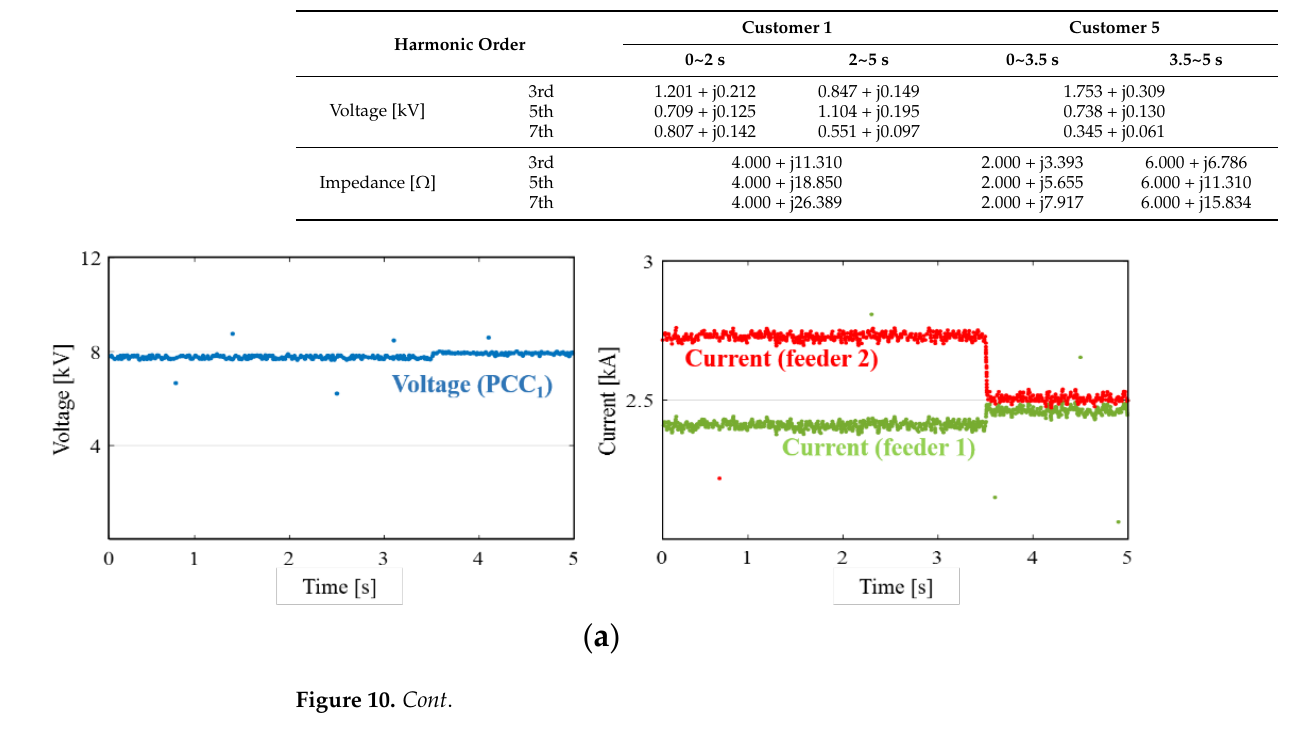
Table 2. The equivalent parameter changes on two customers 1 and 5.